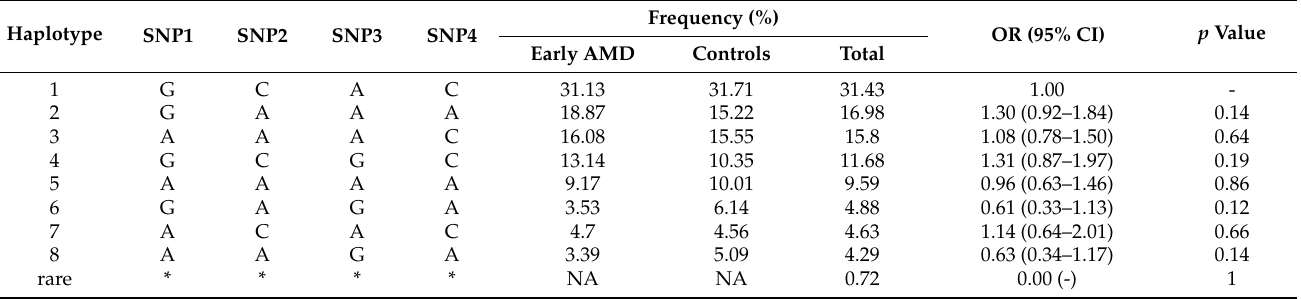
Table 5. Associations between VEGFA haplotypes and risk of early AMD.